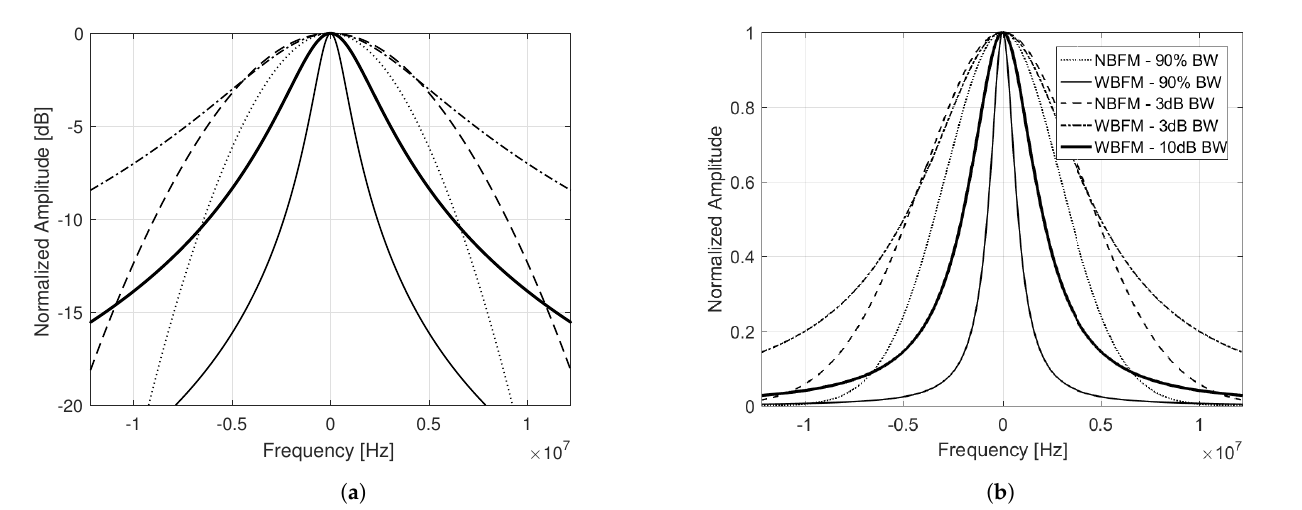
Figure 2. Power spectral density of narrowband (NBFM) and wideband (WBFM) frequency modulated signals with 10 µ s duration, plotted ( a ) in dB and ( b ) in linear scale, considering different combinations of σ a and B a that result in bandwidths B ˜ s = 10 MHz under different criterion.